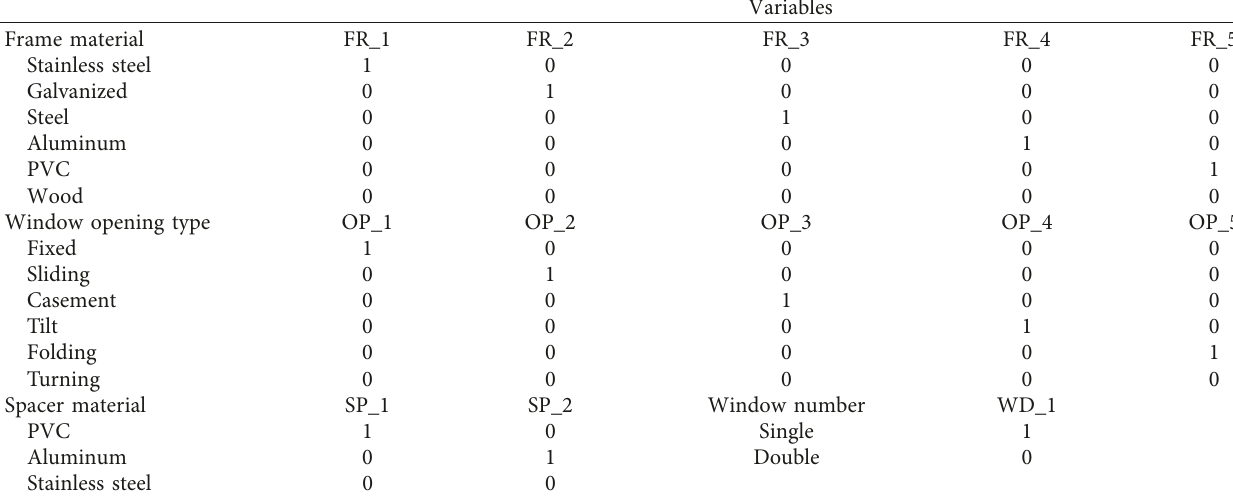
Table 2: Window component settings and coding of nominal scale variables for multiple linear regression